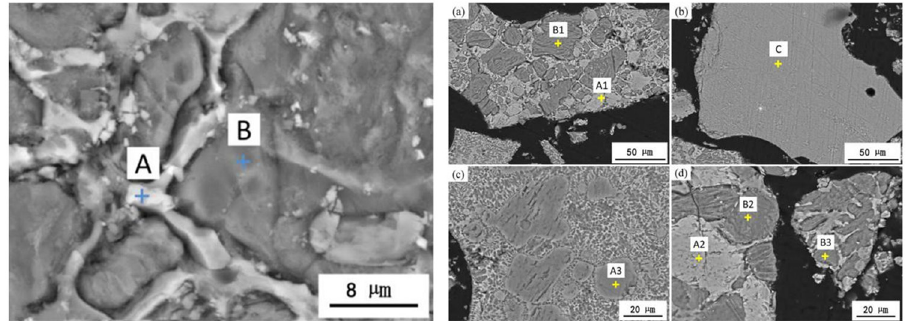
Figure 2: Morphology and EDS analysis of slag backscatter of Baogang Steel ( A – MgO · 2FeO; B – Ca 2 SiO 4 ; A1 – A3 – MgO · 2FeO; B1 – B3 – Ca 2 SiO 3 ; C – Ca 2 Al 2 SiO 7 ) .